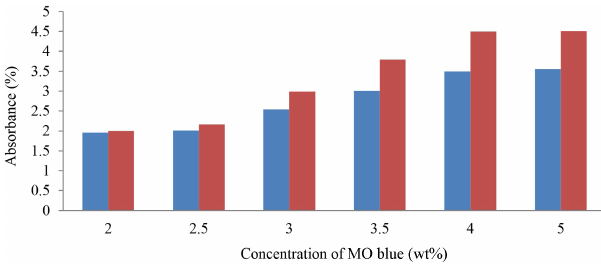
Figure 6. The concentration of MO dye vs. absorbance, with and without irradiation. The blue and red colours signify absorbance with and without radiation respectively.